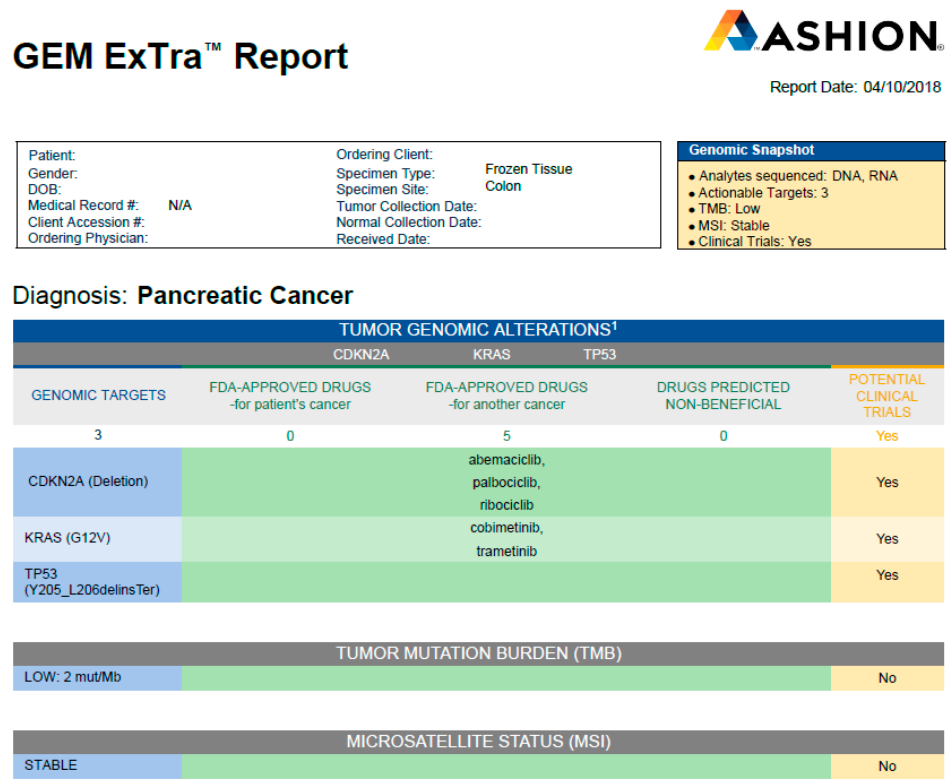
Figure 2. A sample report from the Ashion GEM ExTra test.